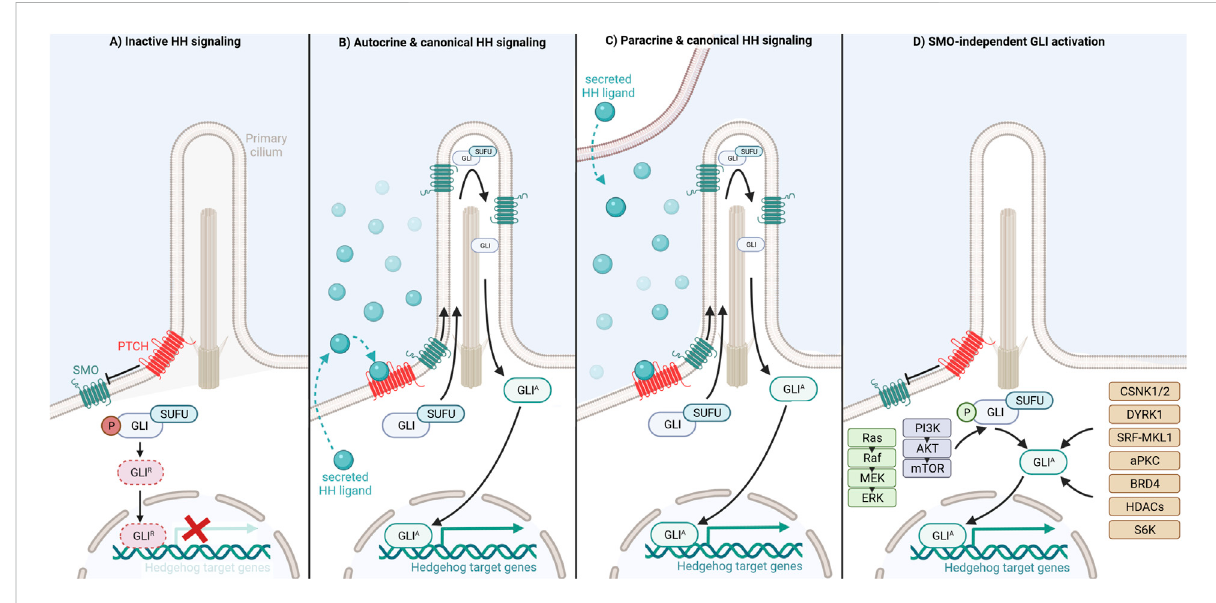
FIGURE 1 Activation and distinct regulatory mechanisms of Hedgehog/GLI signaling